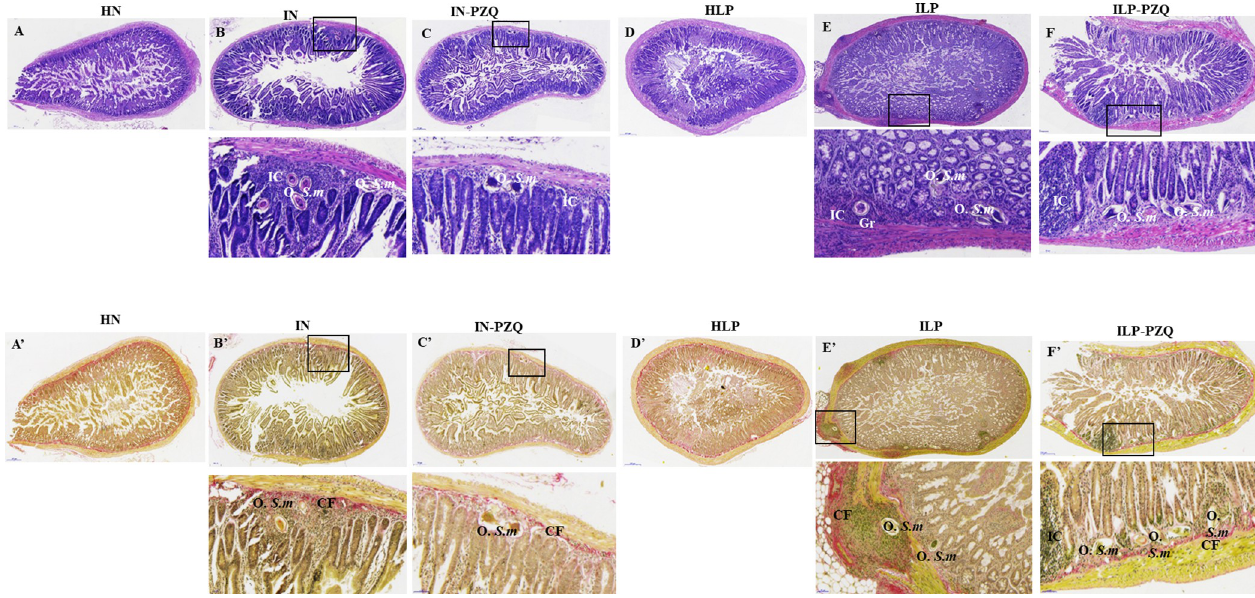
Fig 11. Effects of praziquantel treatment on the intestine histology of Schistosoma mansoni -infected mice receiving a low-protein diet. A, B, C, D E, and F: Hematoxylin-eosin staining A’, B’, C’, D’, E’ and F’: Picrosirius staining Group IN: infected-untreated mice receiving a standard diet; group IN-PZQ: infected mice receiving a standard diet and treated with praziquantel; group ILP: infected-untreated mice receiving a low-protein diet; group ILP-PZQ: infected mice receiving a low-protein diet and treated with praziquantel. IC: inflammatory cells, Gr: granuloma, O. S.m: egg of S . mansoni , CF: collagen fiber.